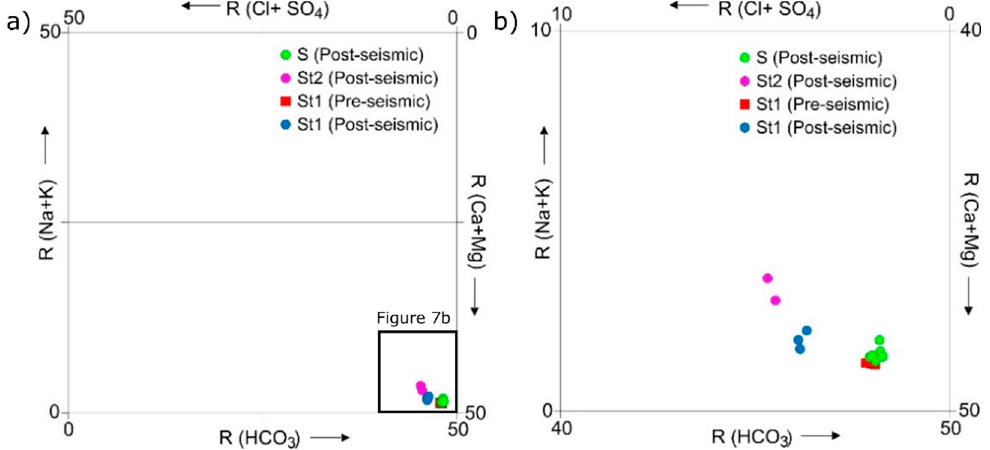
Figure 8. ( a ) Plot of the chemical composition of Campiano stream monitoring points (pre- and post-seismic data are available for St1, while only post-seismic data are available for S and St2) on the Langelier–Ludwig diagram. ( b ) Detail of the Langelier–Ludwig referring to the box reported in ( a ). The mean δ 18 O content that was measured at sampling point St1 during the post- seismic phase (years 2018, 2019 and 2021) is equal to − 9.67 ± 0.16 ‰ vs V-SMOW. By ap- plying the δ 18 O elevation relation obtained by Fronzi et al. [13], a mean recharge area of 1371 ± 48 m a.s.l. is derived. Instead, the mean hydrologic basin elevation upstream to St1 (calculated from the DTM) is about 1106 m a.s.l. This result, together with the tracer test results, suggests that there is an external groundwater contribution towards St1 coming from the Pian Grande Plain (about 1300 m a.s.l.) that collects the rainfall water from the surrounding reliefs (having higher elevation). The mean δ 18 O content that was measured at the S sampling point after the seismic sequence is equal to − 9.87 ± 0.17 ‰ vs V-SMOW. This value corresponds to an elevation of the recharge area that is equal to 1430 ± 51 m a.s.l. It can also be observed that the SO 4 content of this spring is much lower than that observed in St1. This can be explained by observing that the recharge area of S spring is likely to be limited to the top area of Patino Mt., having an average elevation of about 1460 m a.s.l. In this area, part of the outcropping formations, including Calcare Massiccio, are overthrusted above the Maiolica and Scaglia Calcarea complexes (Figure 9) and do not interact with the evaporites, so the SO 4 content is low. 5.4. Hydrogeological Conceptual Model The hydrogeological conceptual model proposed in this study is the result of a com- bined analysis of the geo-structural setting of the investigated area, associated with the outcomes of artificial tracer tests, hydrochemical and isotopic evidence, all validated by a deep observation of the hydrogeological sections. Figure 9 reports the hydrogeological map resulting from this study with schematic cross sections (Apennine and anti-Apennine direction) outlining the main contacts among aquifers and an overall indication of the groundwater flow direction within the Basal aquifer. During the pre-seismic period, re- gional normal faults acted as barriers to groundwater flow in the direction parallel to their strike [6,7], as also highlighted by other studies conducted in the area [14,48]. However, in the post-seismic period, other authors [14,15,48] demonstrated how the increase in per- meability due to the co-seismic ruptures allowed a groundwater transfer from the eastern to the western sectors of the Sibillini Mts. This groundwater transfer has favoured a sig- nificant discharge increase in the co-seismic period in rivers located westward and north- ward of the Sibillini Mts. Massif [10], later followed by a gradual but years-long discharge decrease. This last aspect is also evidenced in this study for the Campiano stream (Figure 3) with discharge values decreasing from about 0.5 m 3 /s to 0.2 m 3 /s in St1 and from about 1.2 m 3 /s to 0.6 m 3 /s in St2.